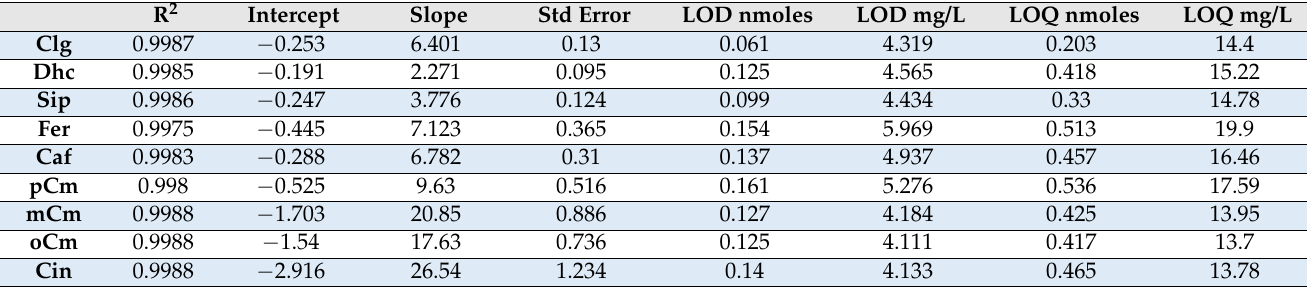
Table 6. Calibration parameters derived from linear regression equations using Tween 20.